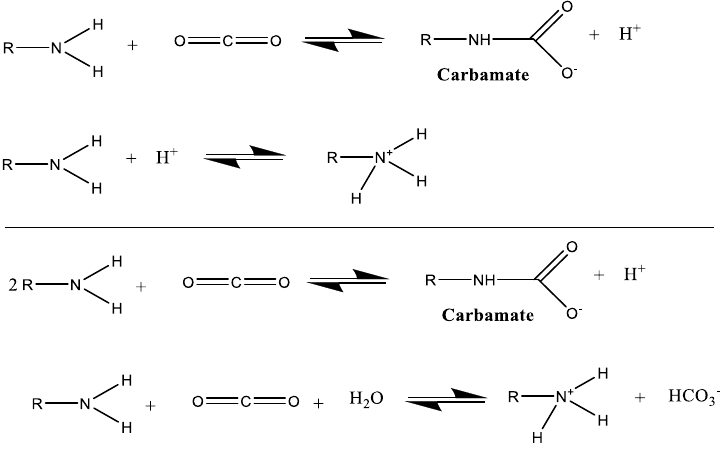
Figure 5. The reaction of a primary or secondary amine with carbon dioxide in the presence of water.